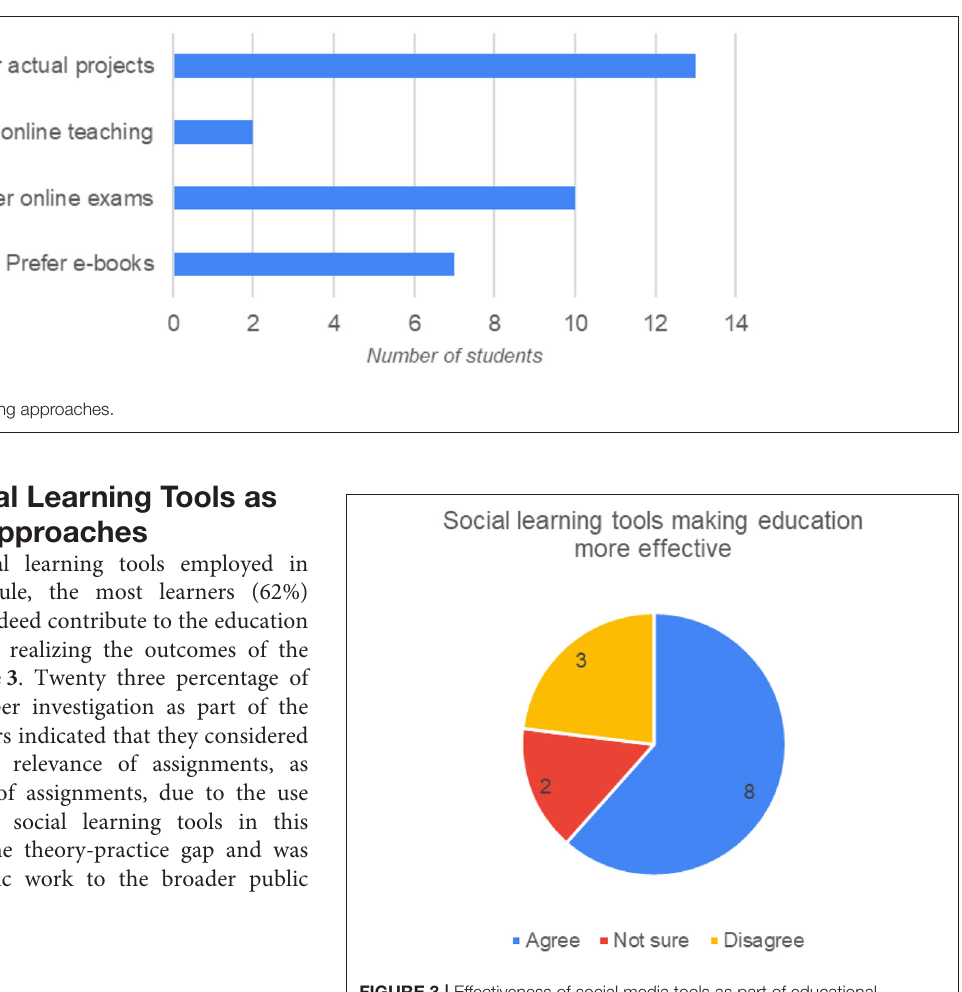
FIGURE 3 | Effectiveness of social media tools as part of educational